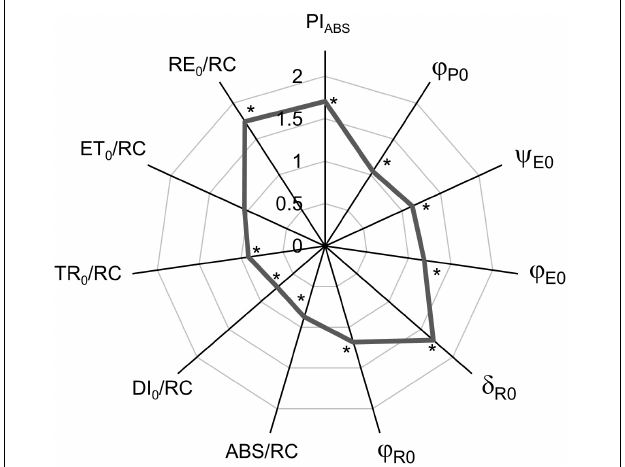
FIGURE 2 | Spider plots display the normalized values of selected parameters of chlorophyll a fluorescence characterizing PSII functioning: performance